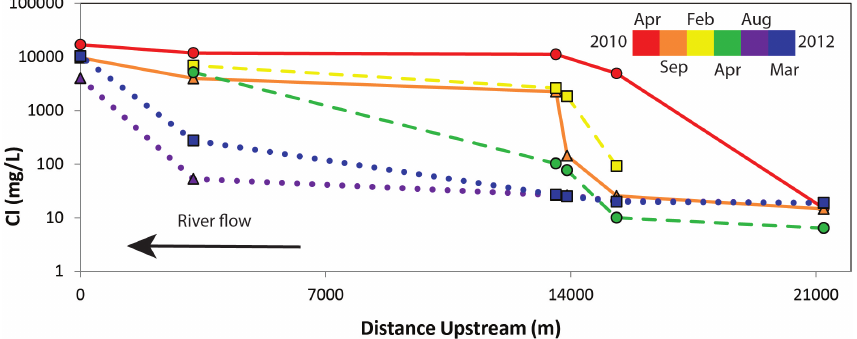
Fig. 7. Distribution of Cl concentrations in water sampled from the Nicholson River over the study period. April 2010=solid line with circles, September 2010=solid line with triangles, February 2011=dashed line with squares, April 2011=dashed lines with circles, Au- gust 2011=dotted line with triangles, March 2012=dotted line with squares.